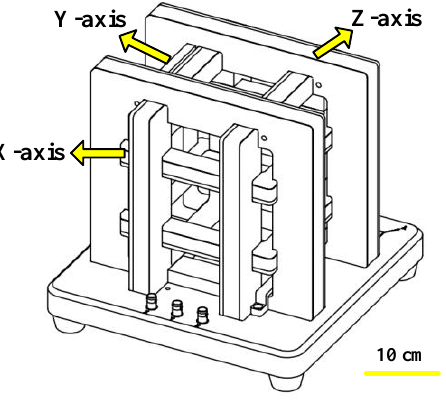
Figure 5. Schematics of the three-axis Helmholtz coils.